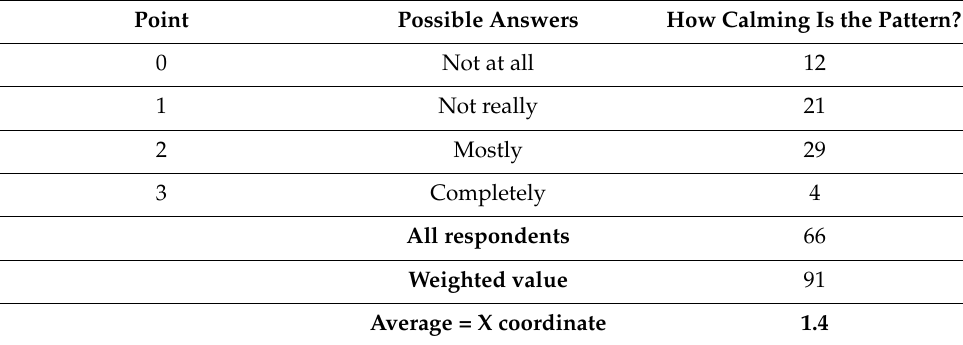
Table 3. Quantification (first pattern—first question—x coordinate).